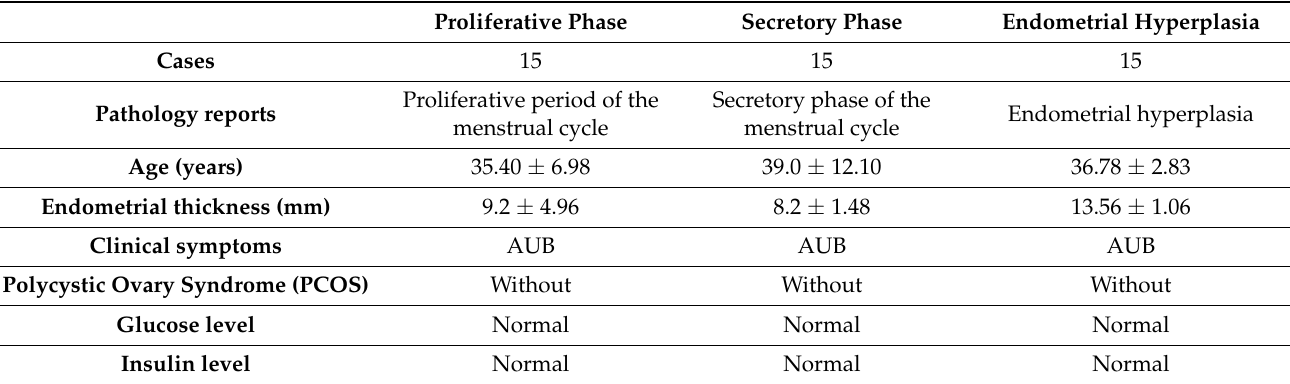
Table 1. Baseline